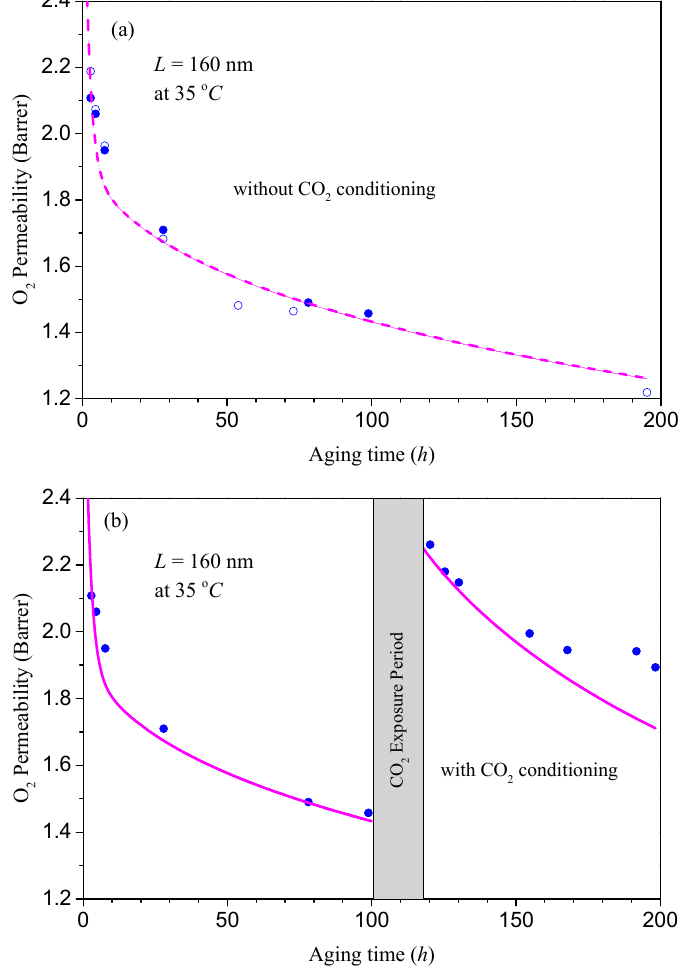
Figure 3. Comparison of the experimental data (symbols) [29] with the model predictions (lines): ( a ) Without CO 2 exposure; ( b ) with short-time CO 2 exposure.